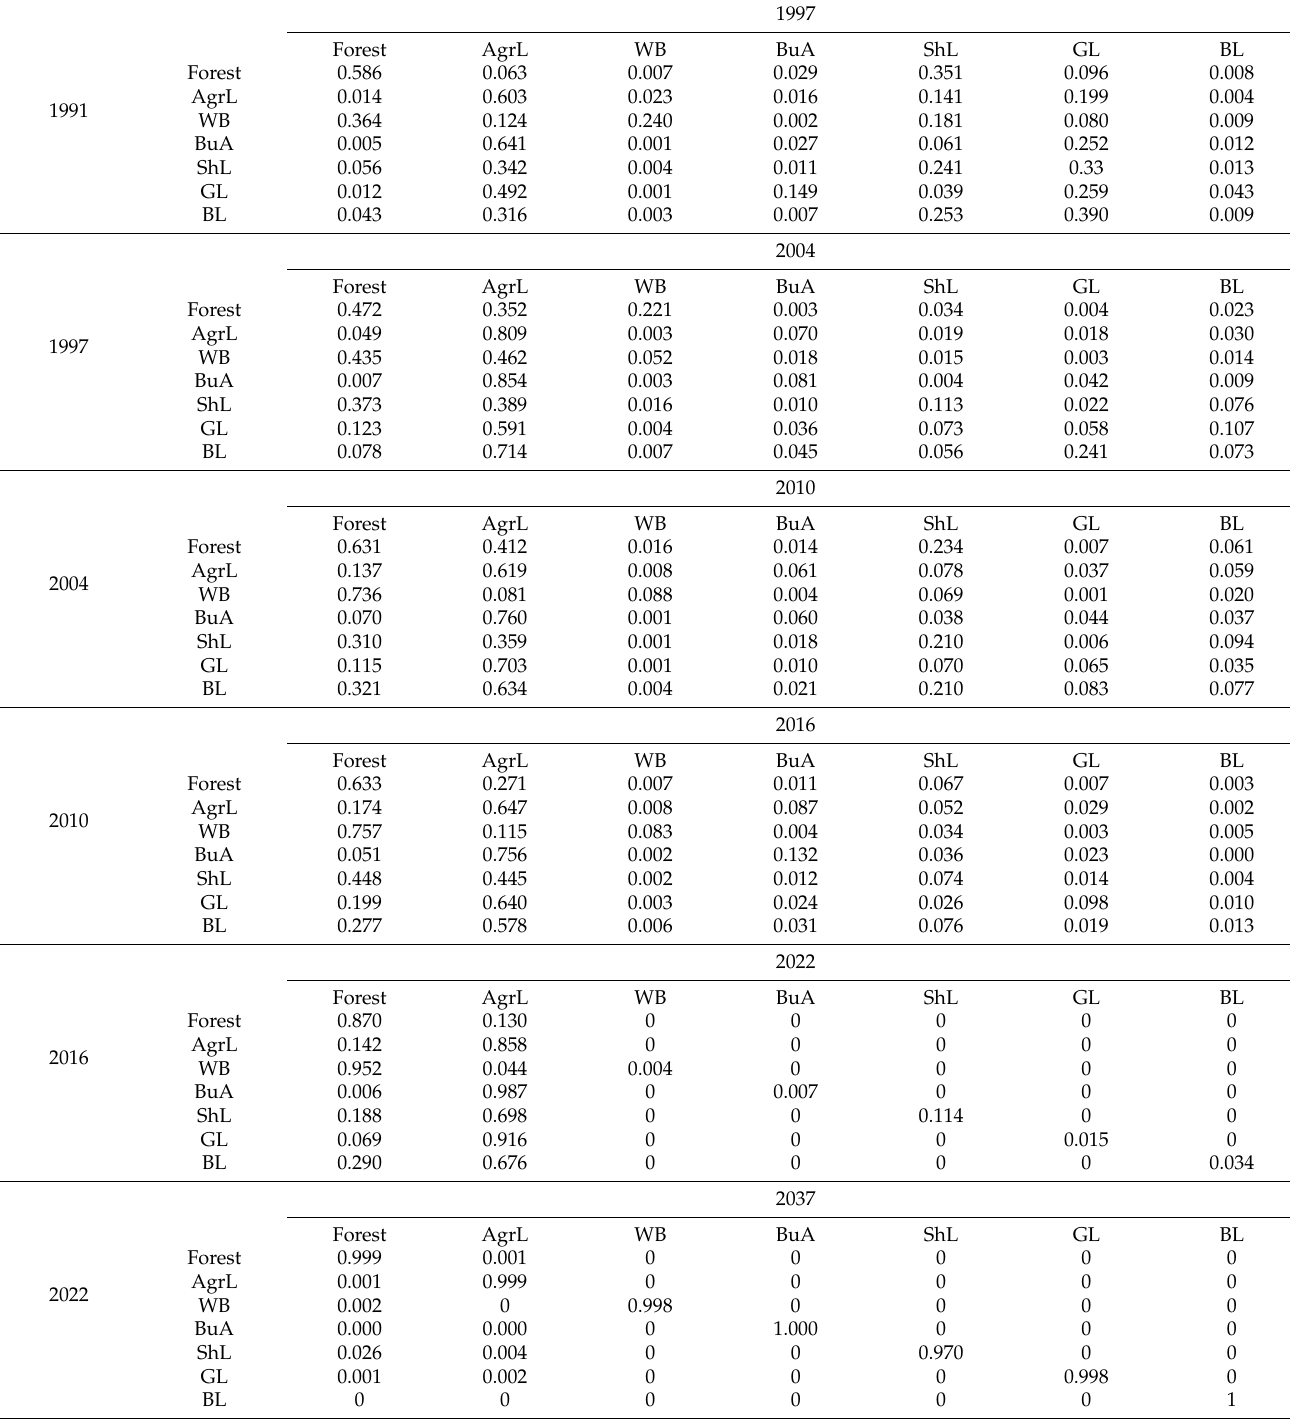
Table 8. Transition matrix of